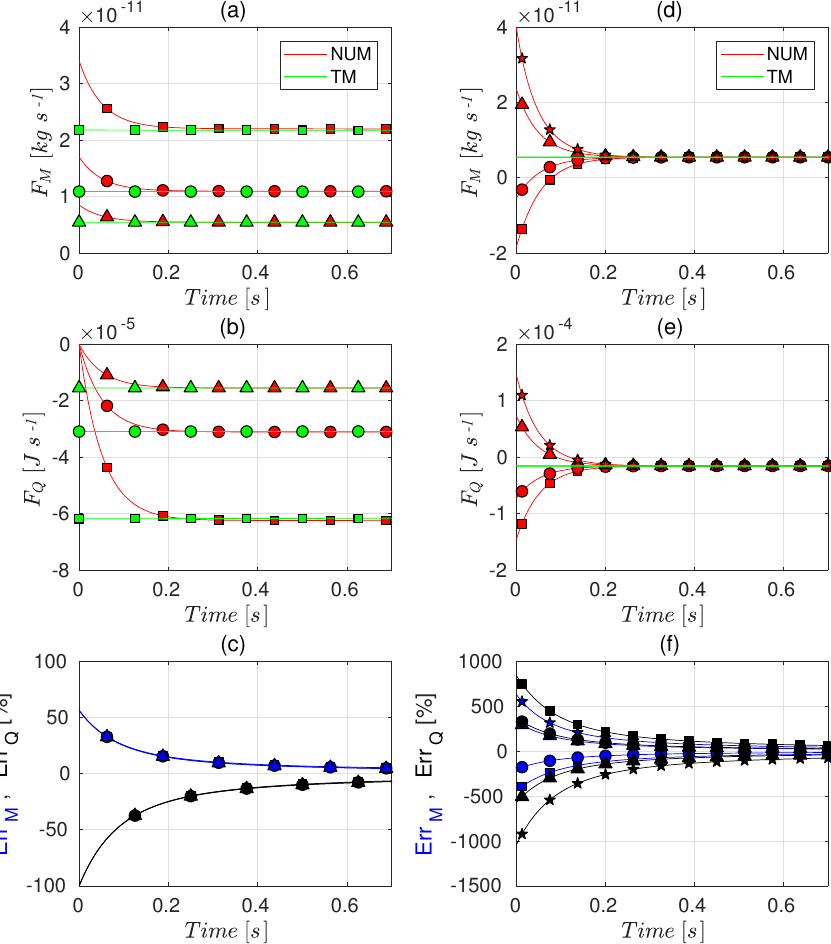
Figure 1. TM and NUM solutions for a particle of 200µm diameter in different environmental conditions. Experiment I-A: (a) rate of mass and (b) heat output with (c) corresponding errors; T p , IC – T a , ∞ = 0, σ ∗ = 0 . 8 (squares), 0.9 (circles), 0.95 (triangles). Experiment I-B: (d) – (f) same as (a) – (c) with σ ∗ = 0 . 95; T p , IC – T Air = − 2K (squares), − 1K (circles), 1K (triangles), 2K